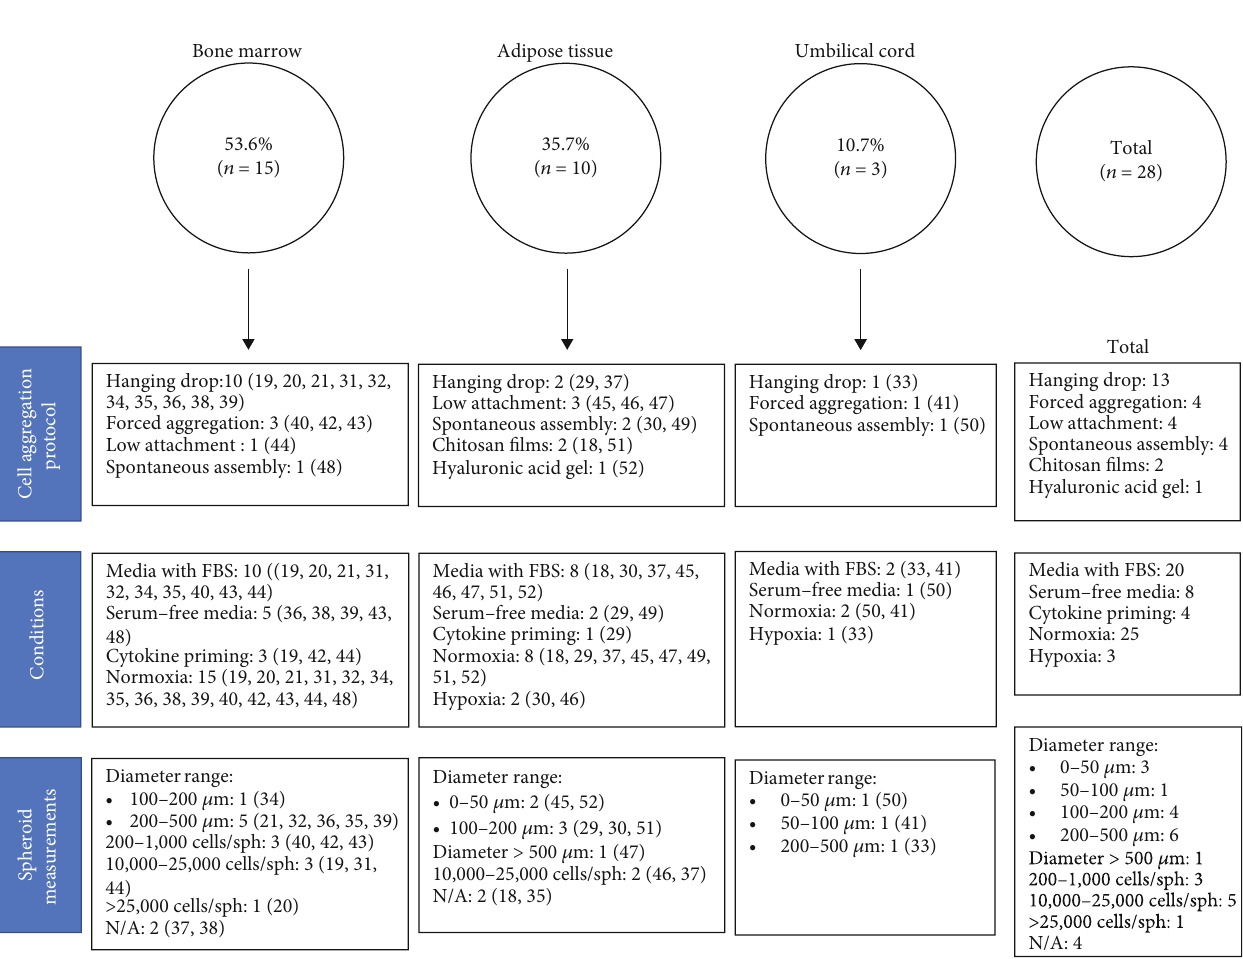
Figure 2: Cell aggregation protocols, culture conditions, and spheroid diameter for selected articles by source of MSC. Article reference number in